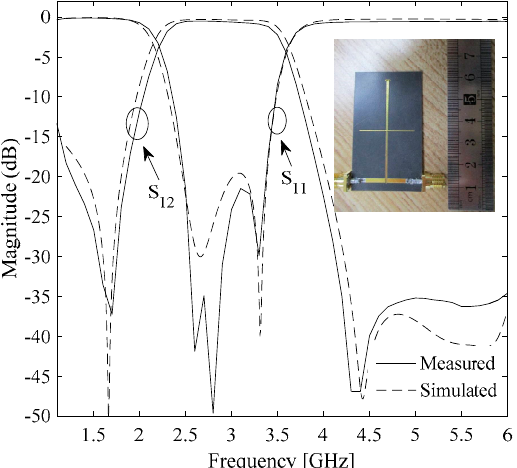
Figure 8. E ff ect of three-line width on quality factor. Figure 8. Effect of three-line width on quality factor.